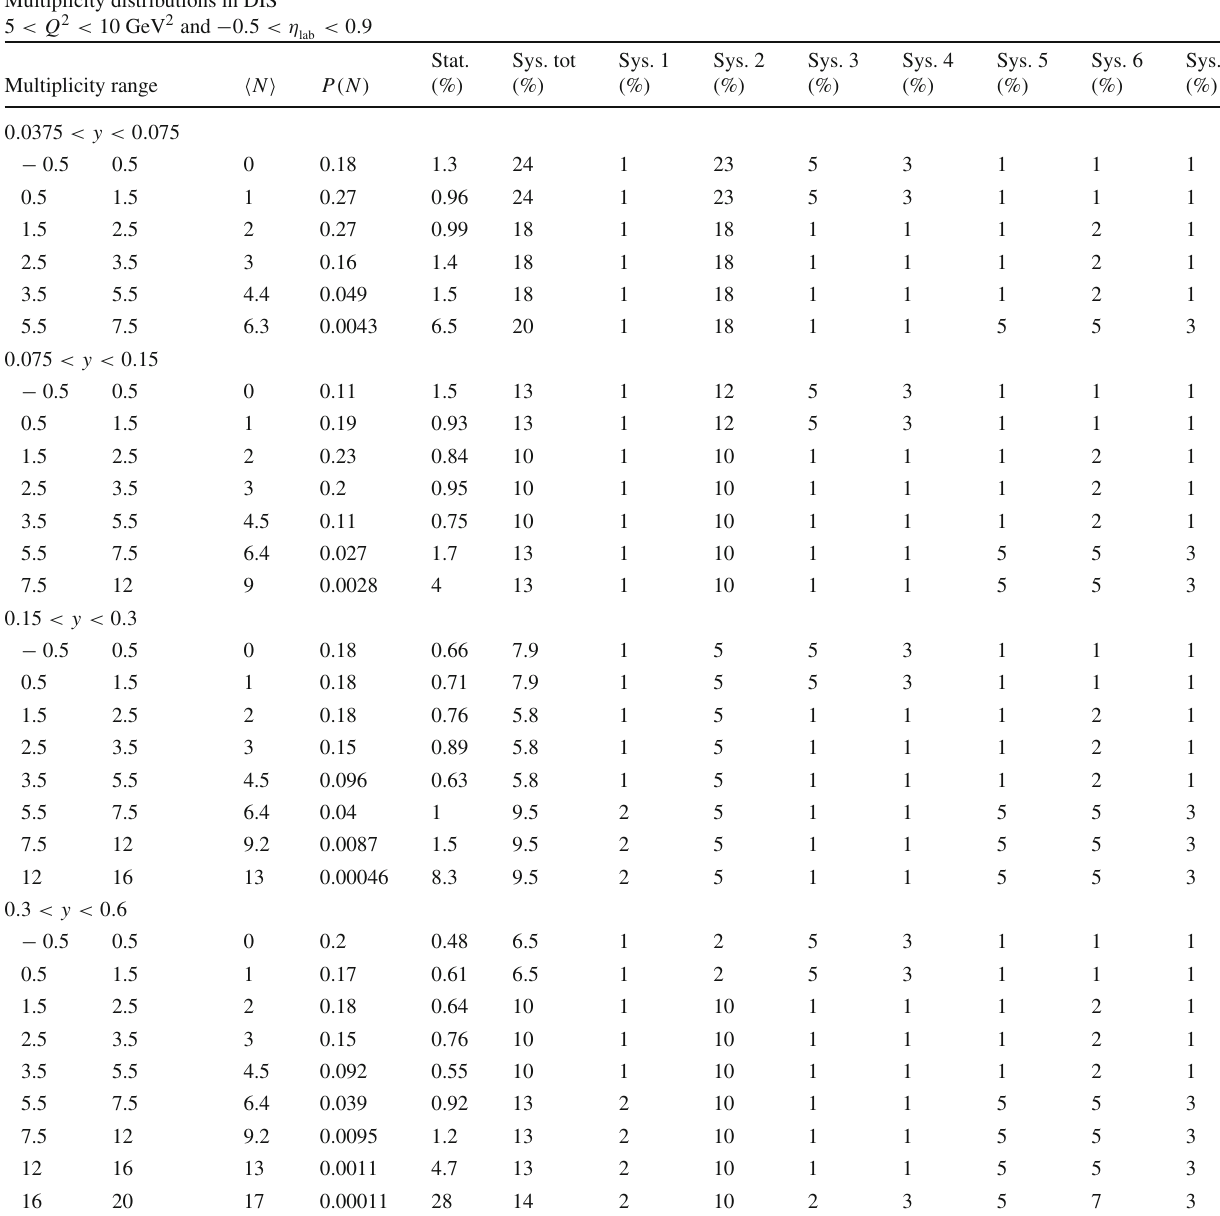
Table 14 Charged particle multiplicity distributions P ( N ) measured √ s = 319GeV with in the ranges of photon virtual- in ep DIS at ity 5 < Q 2 < 10 GeV 2 and charged particle pseudorapidity range Multiplicity distributions in DIS < 0 . 5 < Q 2 < 10 GeV 2 and − 0 . 5 < η lab